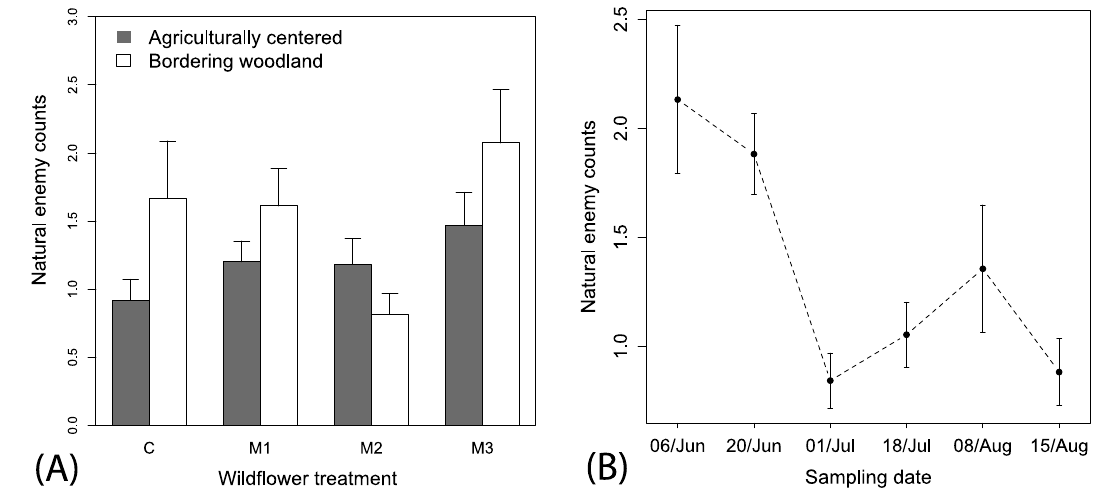
Figure 4. Mean (+1 SE) observations of ( A ) natural enemies among the mixes and local spatial context and ( B ) mean (±1 SE) natural enemies across time.